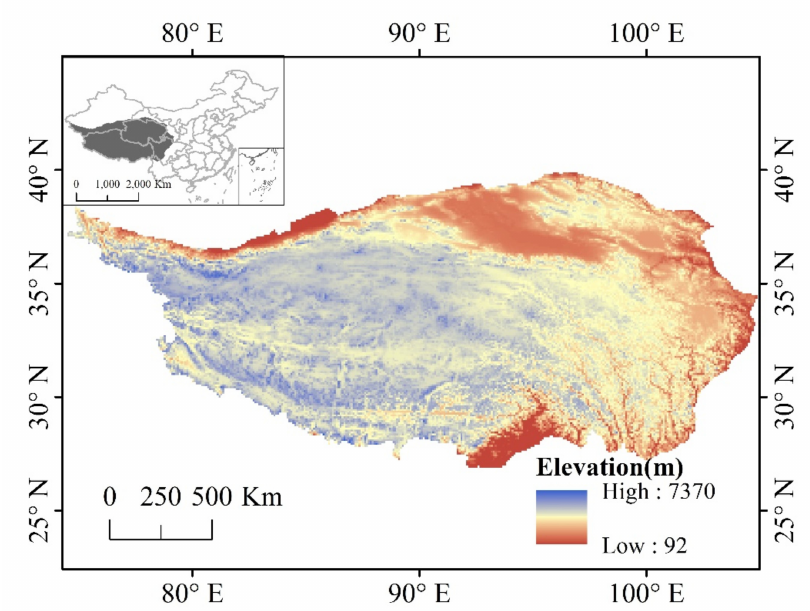
Figure 1. The location and elevation of the study area. The digital elevation data were downloaded from the Resource and Environment Data Cloud Platform (http://www.resdc.cn/ accessed on 14 April